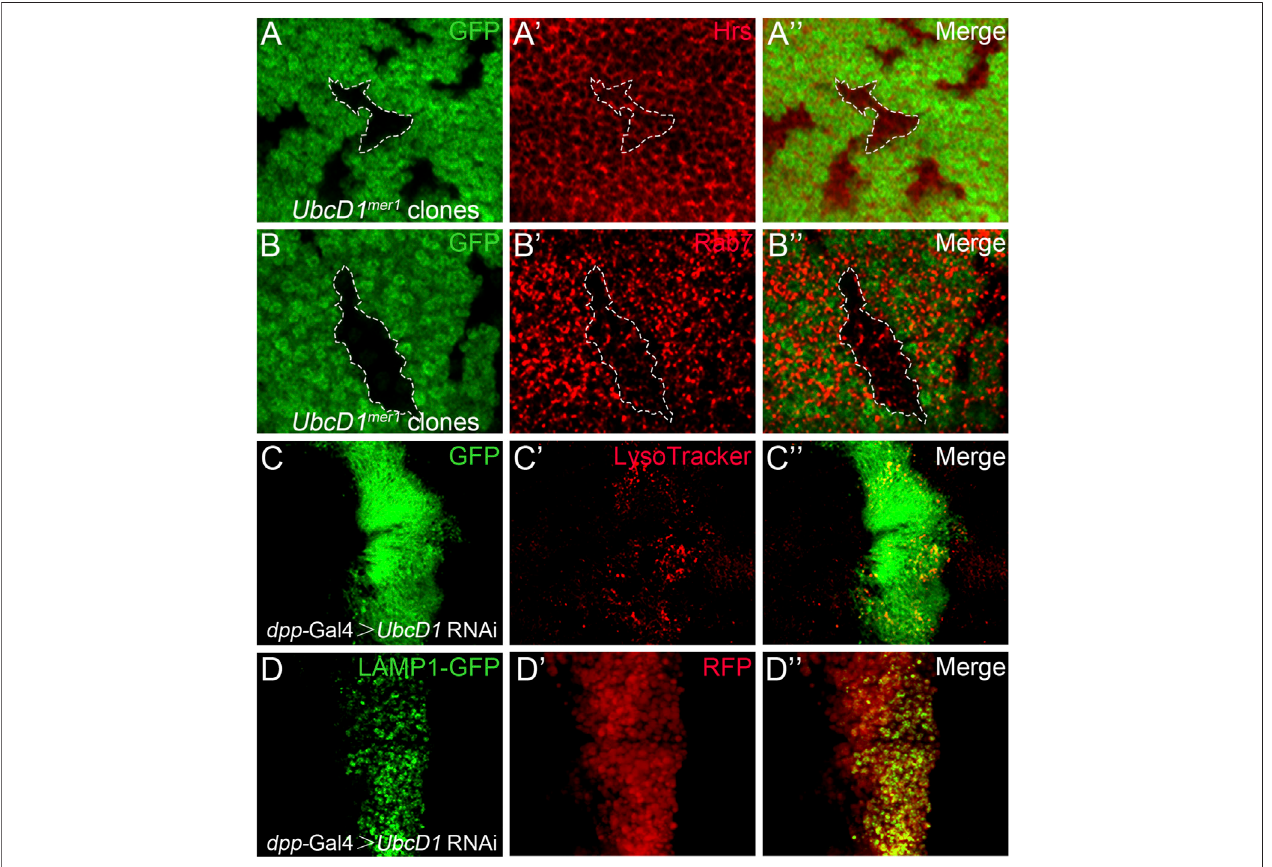
FIGURE 6 | UbcD1 affects endolysosomal machinery. (A – B) In UbcD1 mer1 mutant cells, Hrs positive early endosomes are not affected (A) while Rab7 association with endosomes are reduced (B) . Mutantclones are marked by absence of GFP. Representative mutant clones are circled by dashed lines. (C – D) In UbcD1 RNAi cells, accumulation of LysoTracker (C) and GFP-LAMP1 (D) are evident. The RNAi expressing cells are marked by GFP (C) or RFP (D) . Panels (A – D) are magni fi cation of a portion of Supplementary Figure S3 .